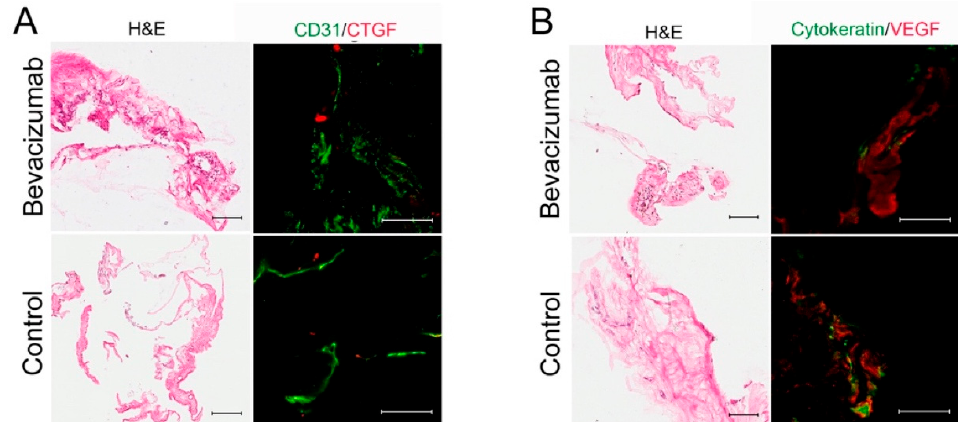
Figure 9. Representative hematoxylin and eosin (H&E) and immunofluorescence images from four patients’ membranes in a randomized controlled trial. Co-labeling of antibodies for ( A ) CD31 (Green)-CTGF (Red) and ( B ) cytokeratin (Green)-VEGF (Red). Note the H&E-stained sections do not correspond precisely to the cytokeratin-labeled sections. While intravitreal bevacizumab did not significantly decrease CTGF (A-top panels) or VEGF (B-top panels) expression in membranes compared to sham group, VEGF was still expressed in membranes of eyes given bevacizumab ( B , right panels). Scale bar = 100 µ m. Abbreviations: CTGF: connective Tissue Growth Factor; VEGF: vascular endothelial growth factor. Adapted from Jiao et al. [174].